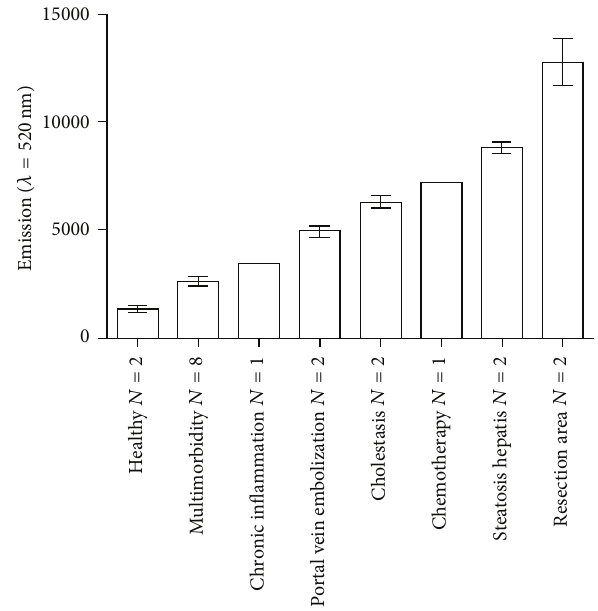
Figure 2: Initial KC activation . Initial ROI levels correlated with tis- sue quality and donor anamnesis. Initial ROI levels were measured in KC cultures by means of the DCF assay performed directly after KC isolation. Data show means ± SEM. 𝑁 : shown in the figure.